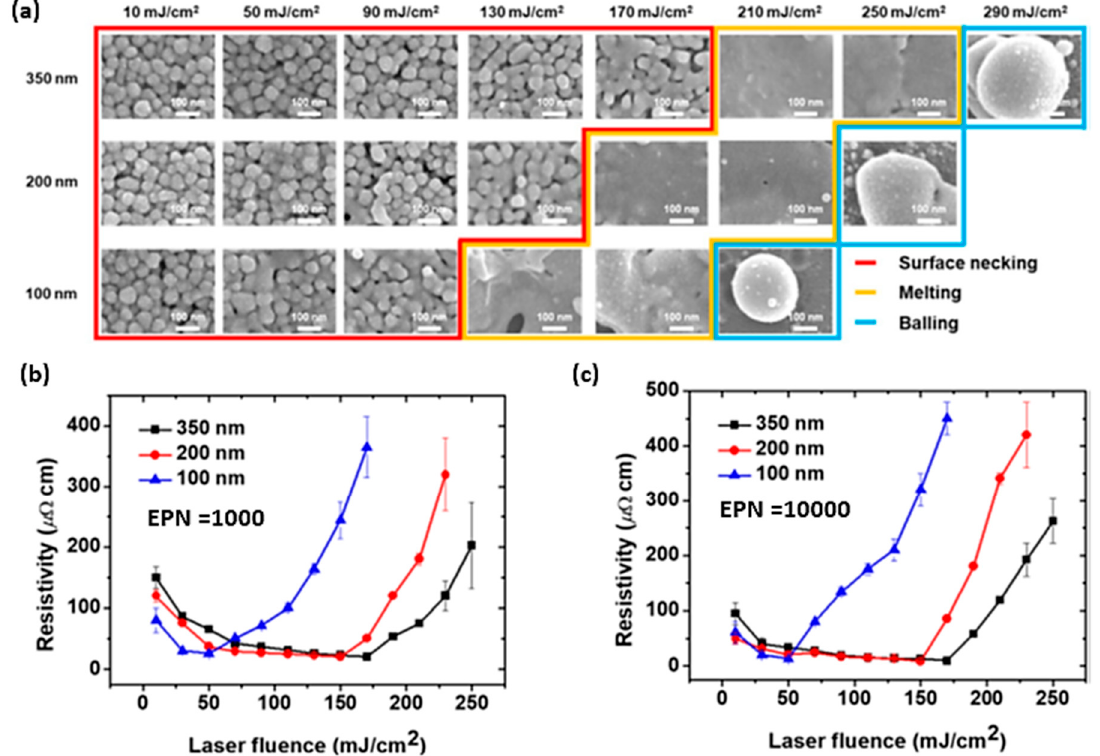
Figure 22. ( a ) Microstructures of fs sintered Ag particles during surface necking and melting stages. Variations in the resistivity of sintered Ag films as a function of fluence; ( b ) Np = 1000; ( c ) Np = 10,000 (Adapted from reference [172]).